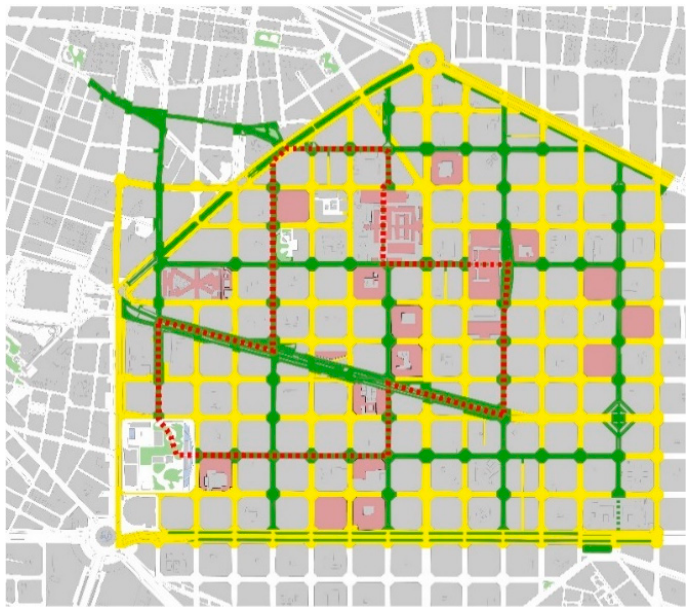
Figure 7. Proposed health routes (dotted red lines) linked to pedestrian and cycling routes (green lines) in the L’Eixample district (highlighted in yellow). The axes were not called green yet, although they were represented in this color. Source: Generalitat de Catalunya [48].